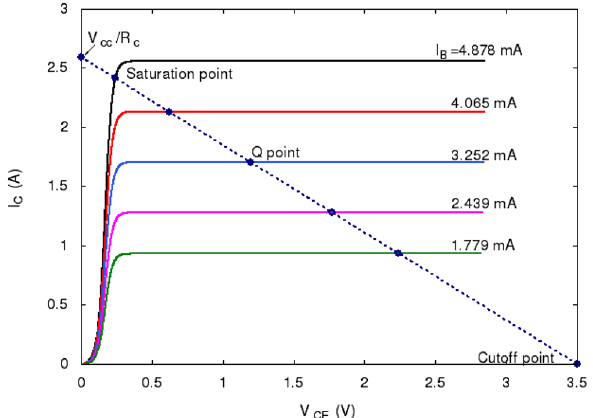
Figure 6. Current-voltage characteristics, load line and their interception points for several specific base currents I b s. The collector doping concentration used to obtain these results is N D = 2.5 · 10 parameters of the transistor are given in the